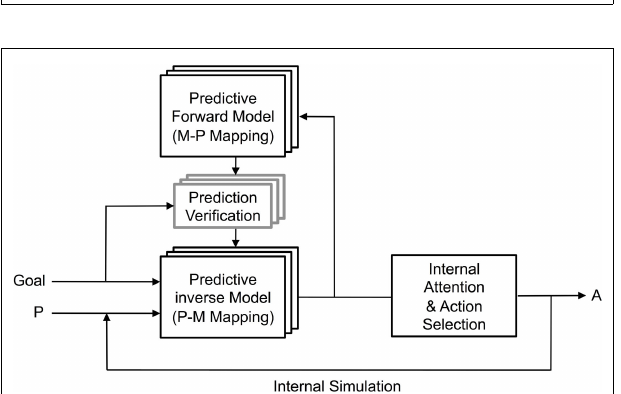
FIGURE 4 | Prospection by internal simulation achieved by (A) direct perceptuo-motor mappings as envisaged, e.g., by Hesslow (2002, 2012), and by (B) joint perception and motor memory mapping as envisaged, e.g., by Shanahan (2006) .